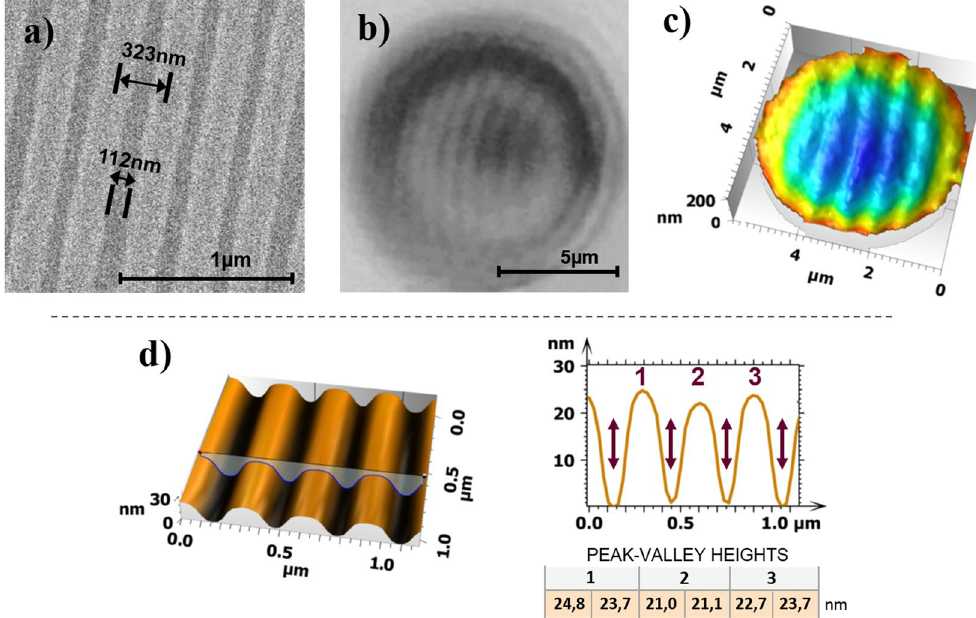
Figure 5. Blu-ray Disc: ( a ) SEM image and a groove measurement. ( b ) 2D image through microsphere. ( c ) Uncorrected 3D image with aberrations measured by microsphere assisted interferometry. ( d ) AFM 3D and cross sectional profile showing resolved grooves 21.0–24.8 nm deep.